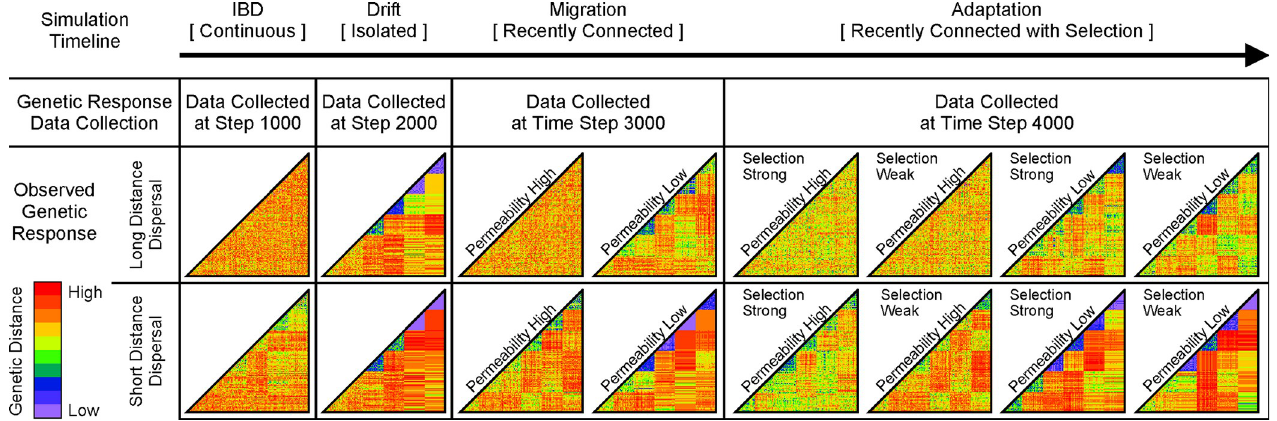
Fig 4. Modeling gene-flow for four landscape histories, beginning with IBD only, and building to a complex history of sequential epochs incorporating IBD, drift, migration, and finally, local selection. The resulting pairwise genetic distance matrices (colored triangles) illustrate the strength of gene-flow within a given landscape history, where increasing contrast in the geometric patterns visible within the matrices results from reduced gene-flow between landscape patches. Data collected at time step 4000 illustrate the interacting effects of gene-flow and local adaptation on genetic-distance. See Methods section for additional